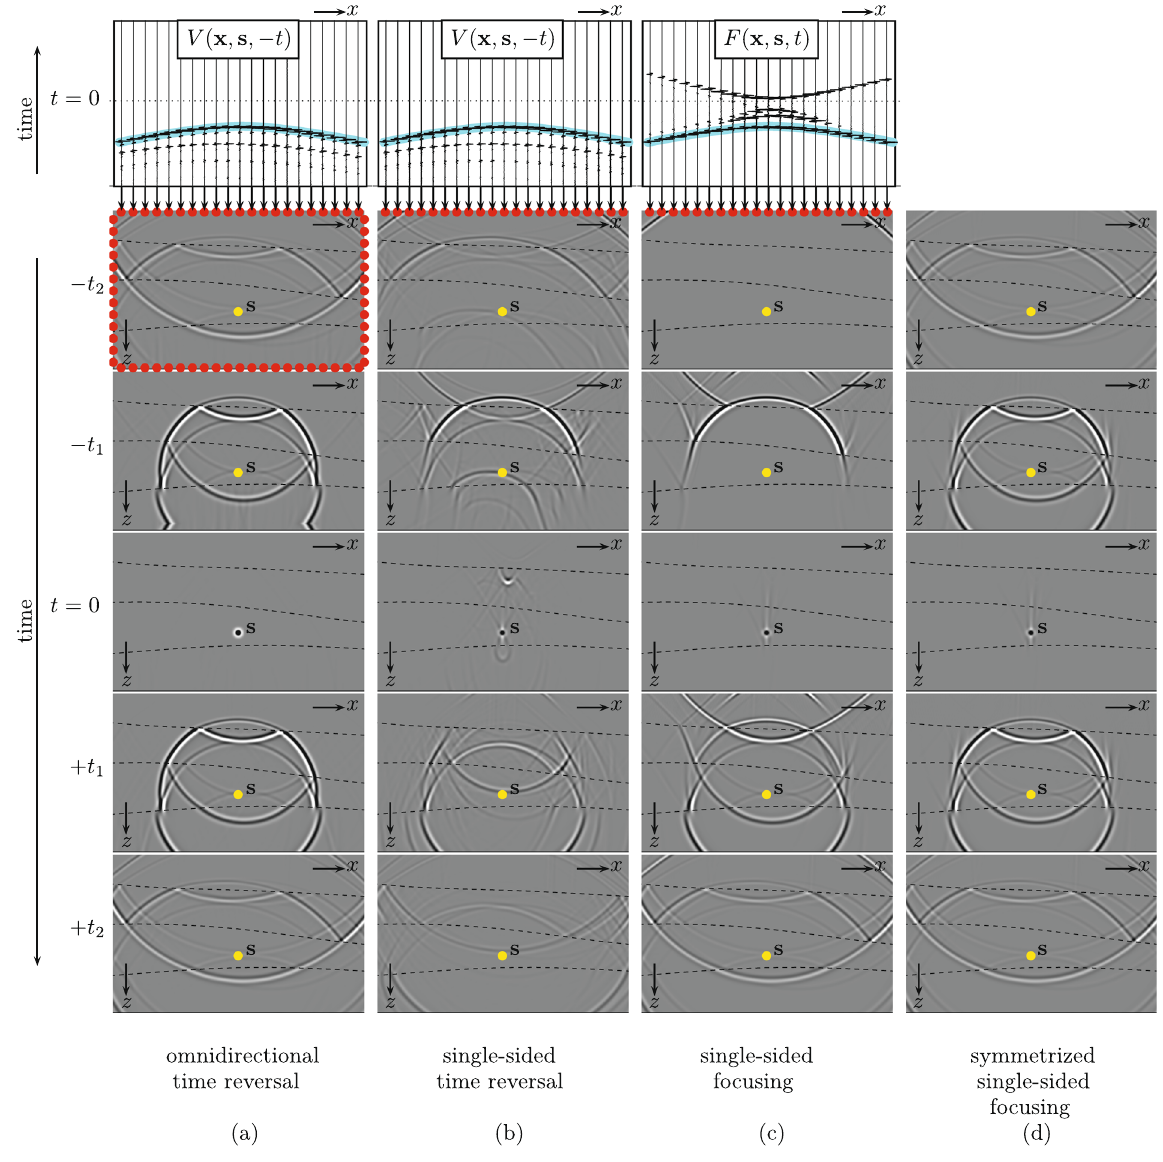
Figure 1. Illustration of virtual-source methods. ( a ) A time-reversed point source response is emitted from the enclosing boundary into the inhomogeneous medium. For negative time, it converges towards the focal point, where it focuses at t = 0. Subsequently, the focal point acts as an omnidirectional radiating virtual source. ( b ) Emission of the time-reversed response from the upper boundary only. Ghost foci occur at t = 0. The virtual source radiates mainly downward. ( c ) Emission of a single-sided focusing function from the upper boundary only. No ghost foci occur at t = 0. The virtual source radiates mainly downward. ( d ) Symmetrizing the previous result. No ghost foci occur at t = 0. The virtual source is